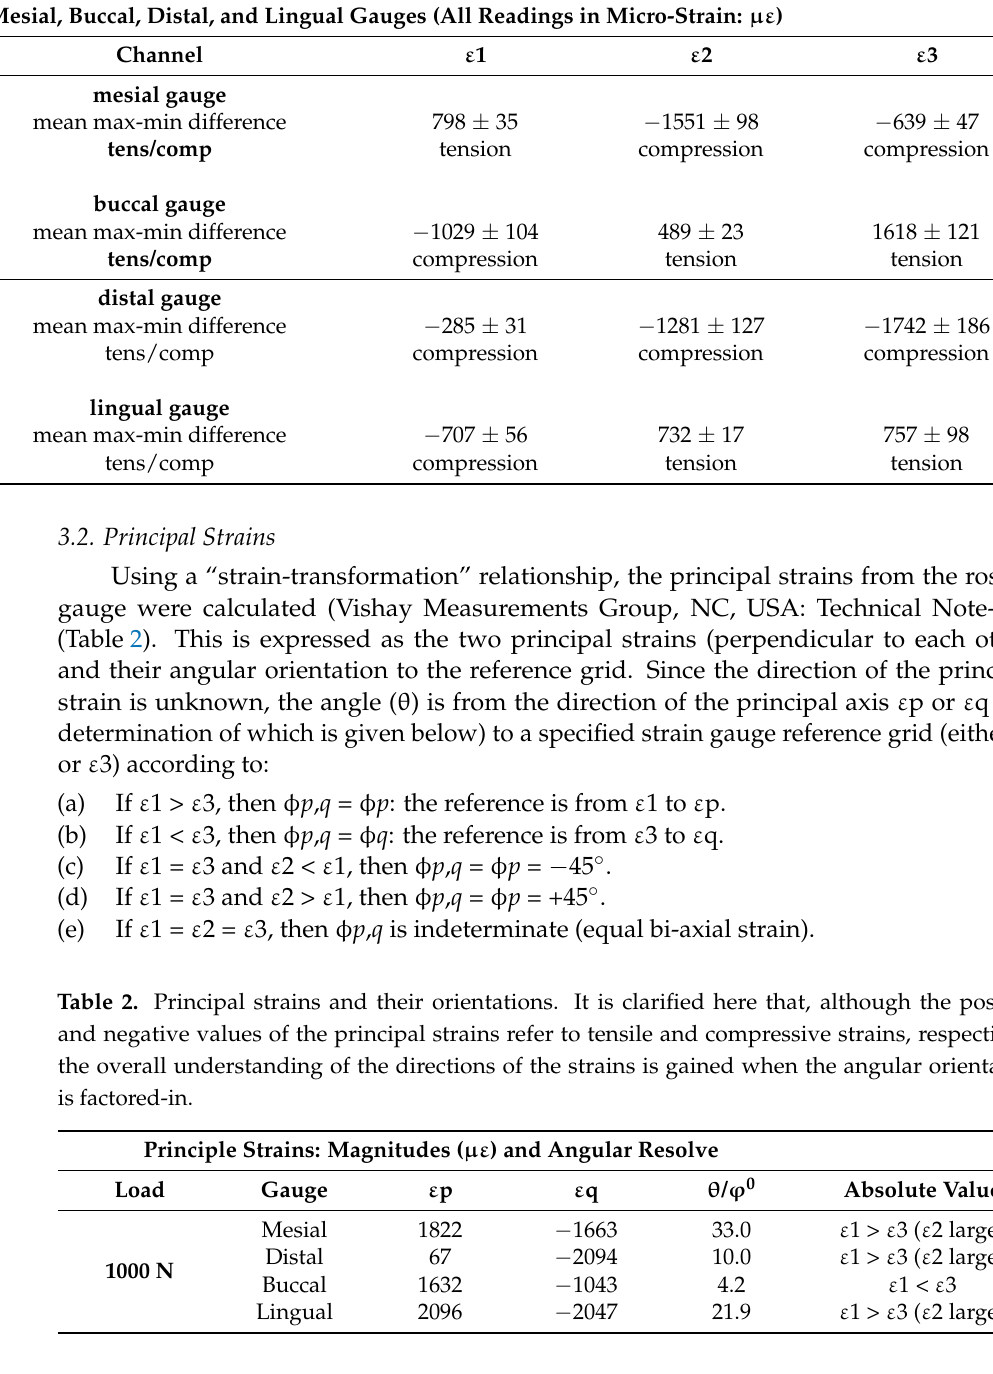
Table 1. The overall mean amplitudes of each gauge output were derived as the mean difference between the maxima and minima of each channel.